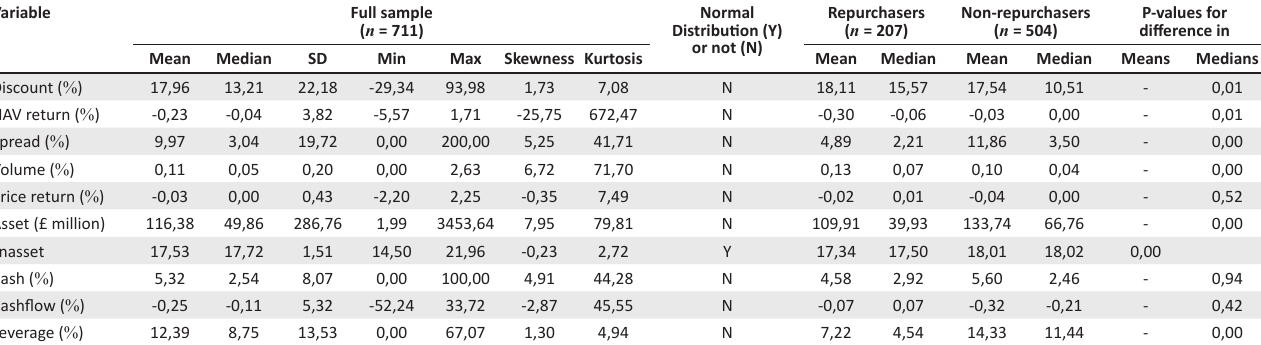
TABLE 5: Descriptive statistics and univariate test for repurchase and non-repurchase fund-years. Variable Full sample